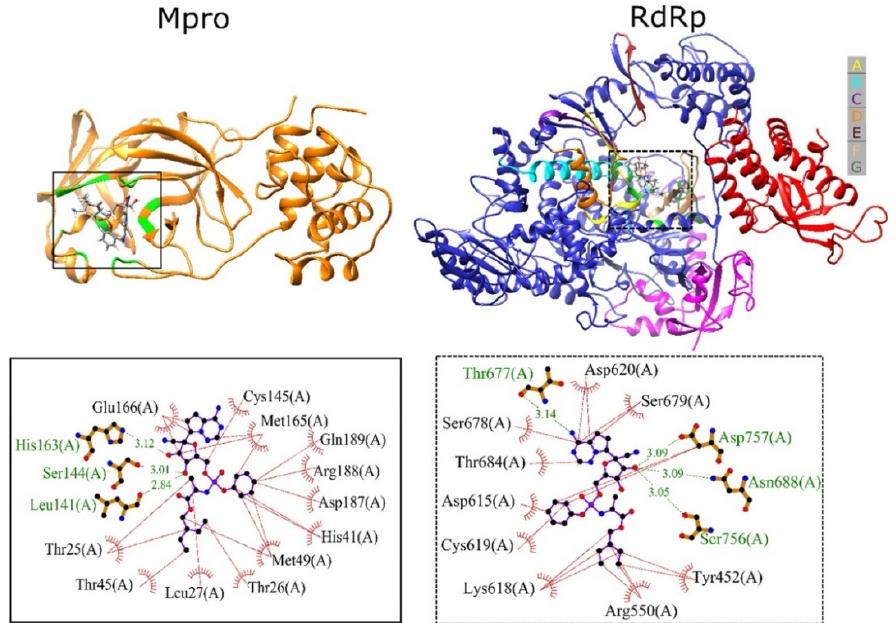
Figure 10. Remdesivir’s binding site in complex with Mpro and RNA polymerase [51]. Permission and copyright©2020, American Chemical Society.